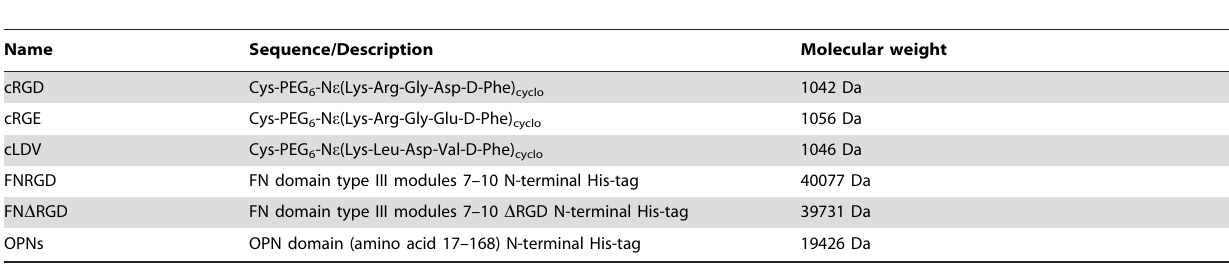
Table 2. Short peptide binding motifs and protein domains used for biofunctionalization of gold NP